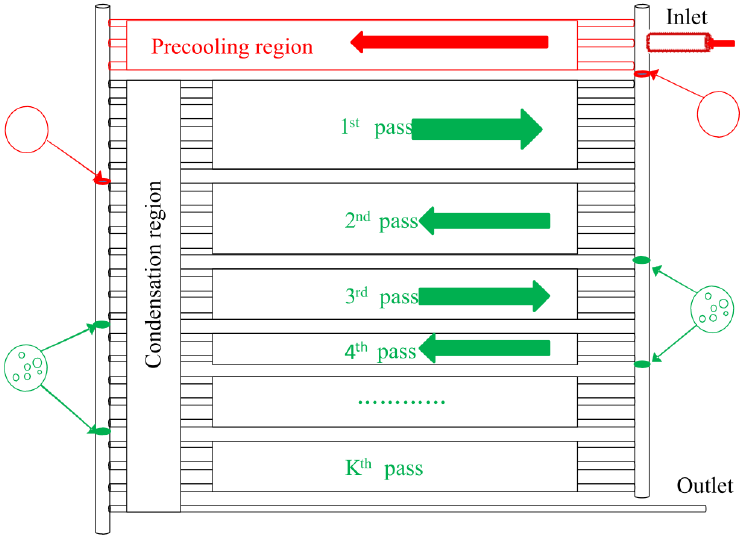
Figure 9. Model of a liquid-separated fin-and-tube condenser [70]. Reproduced with permission from Yi et al., Journal of Cleaner Production; published by Elsevier, 2018.